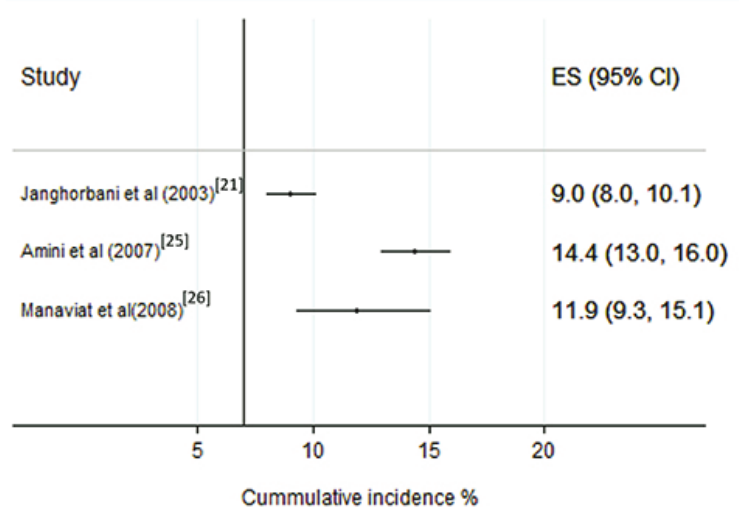
Figure 3. Forest plot of cumulative incidence rate of diabetic retinopathy. CI, confidence interval; ES, estimation of diabetic retinopathy incidence (%)